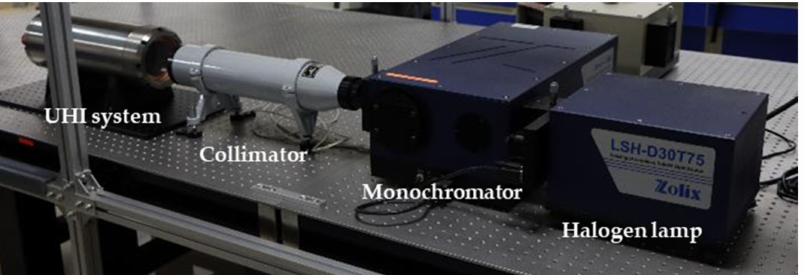
Figure 3. The spectral calibration instruments of the designed UHI system. From left to right are the collimator (FPG-6C, Huazhong Precision Instrument, China), the grating monochromator (Omni- λ 500, Zolix, China), and a halogen lamp (LSH-D30T75, Zolix, China).